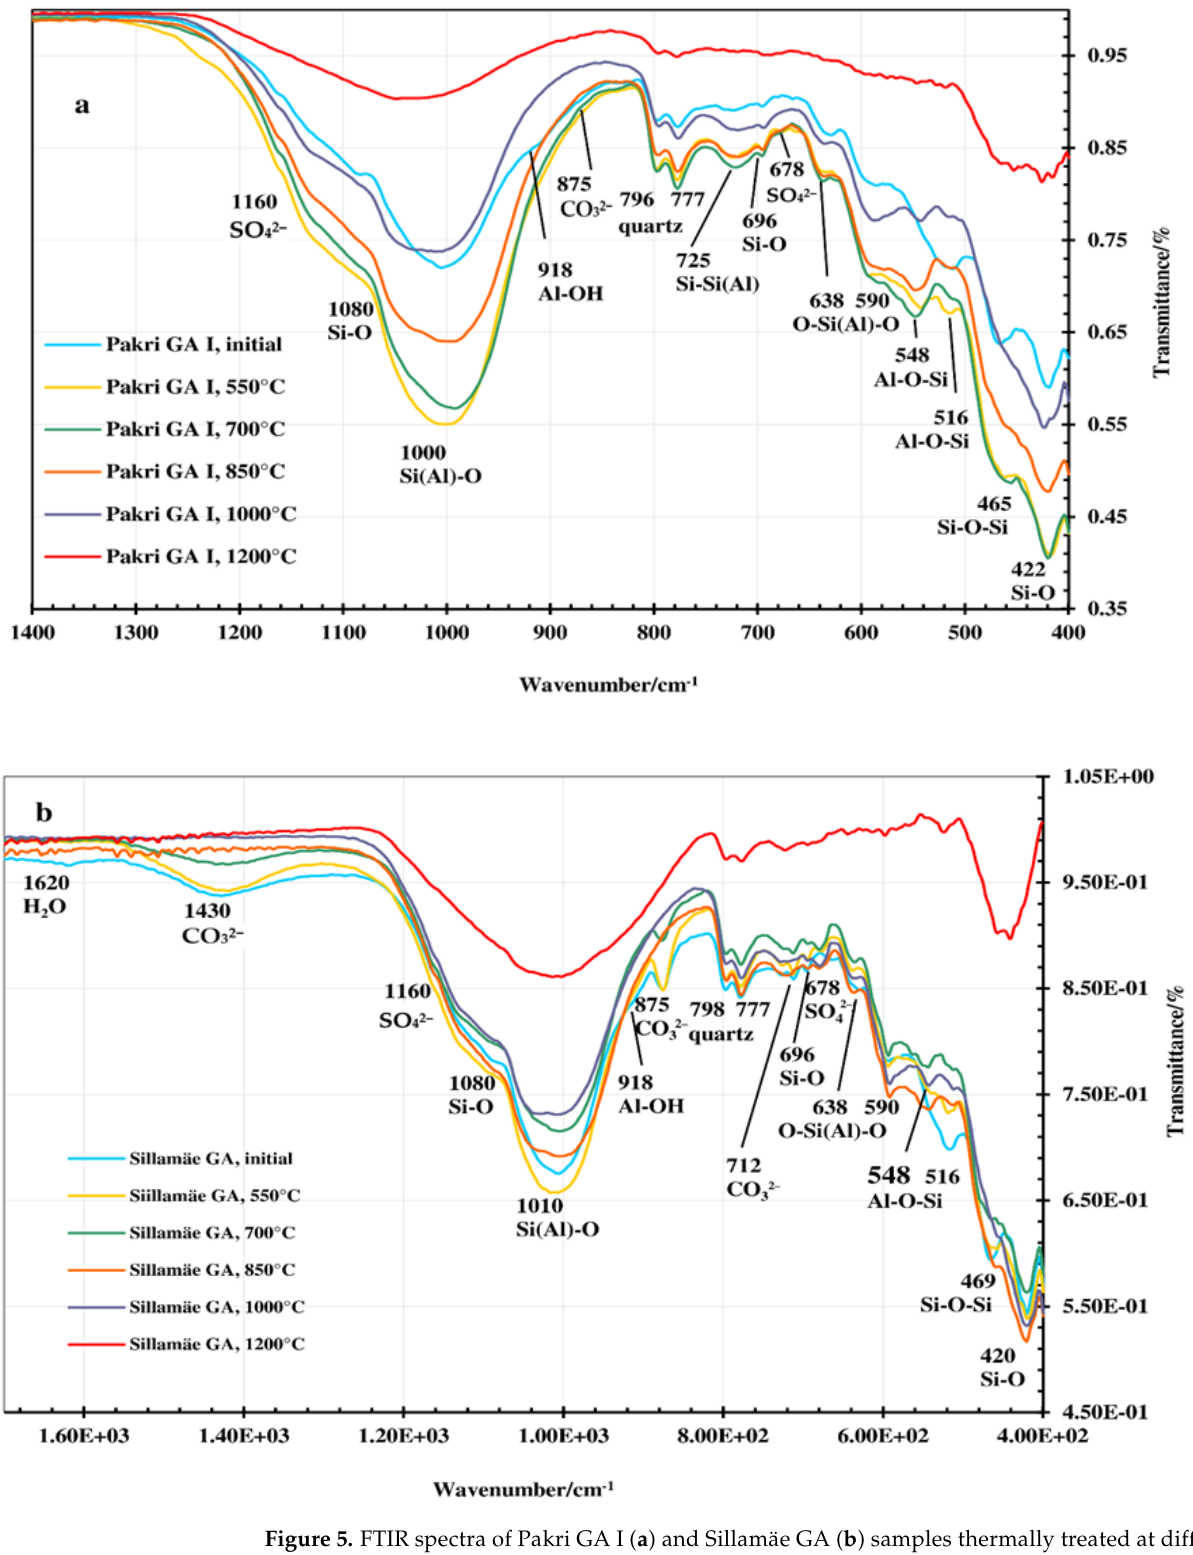
Figure 5. FTIR spectra of Pakri GA I ( a ) and Sillamäe GA ( b ) samples thermally treated at different temperatures.